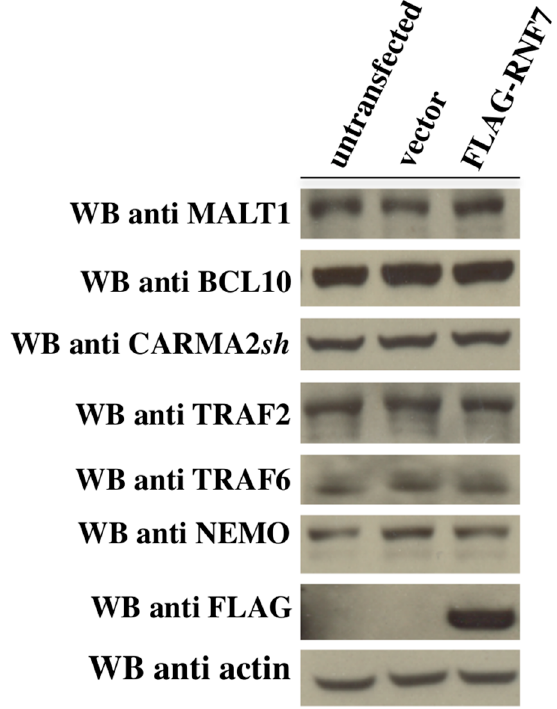
Figure 6. The CARMA–BCL10–MALT1 (CBM) complex expression level was not affected by RNF7. HEK293T cells were left untransfected or transfected as indicated. Twenty-four hours later, lysates were prepared and the expression level of the indicated proteins was monitored by immunoblot assay. CARMA: CARD-containing MAGUK.